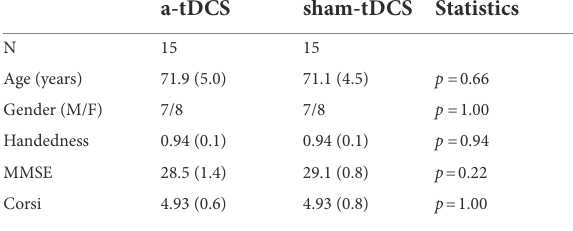
TABLE 1 Summary of groups